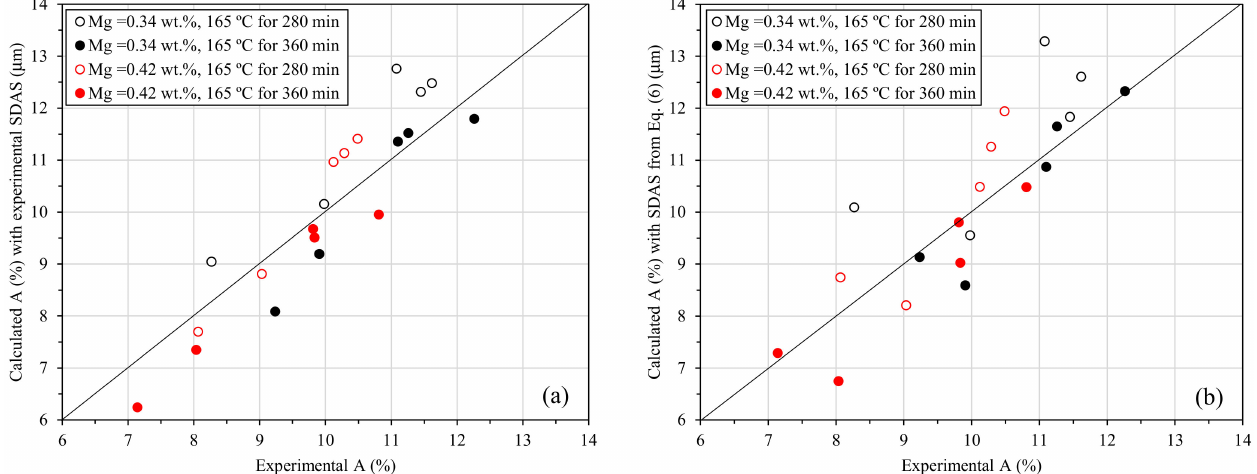
Figure 23. Comparison of experimental A values obtained from the SK-7 castings and those pre- dicted by using Equation (29) and data included in Table 11. Two different SDAS parameters are used: experimentally measured SDAS ( a ) and the values of this parameter determined with Equation (6) ( b ). Black symbols correspond to SK-7 castings manufactured with 0.34 wt.% Mg while red symbols correspond to castings produced with 0.42 wt.% Mg. In both cases, open and solid circles represent those castings aged at 165 ◦ C for 280 min and for 360 min, respectively. Solid lines are the